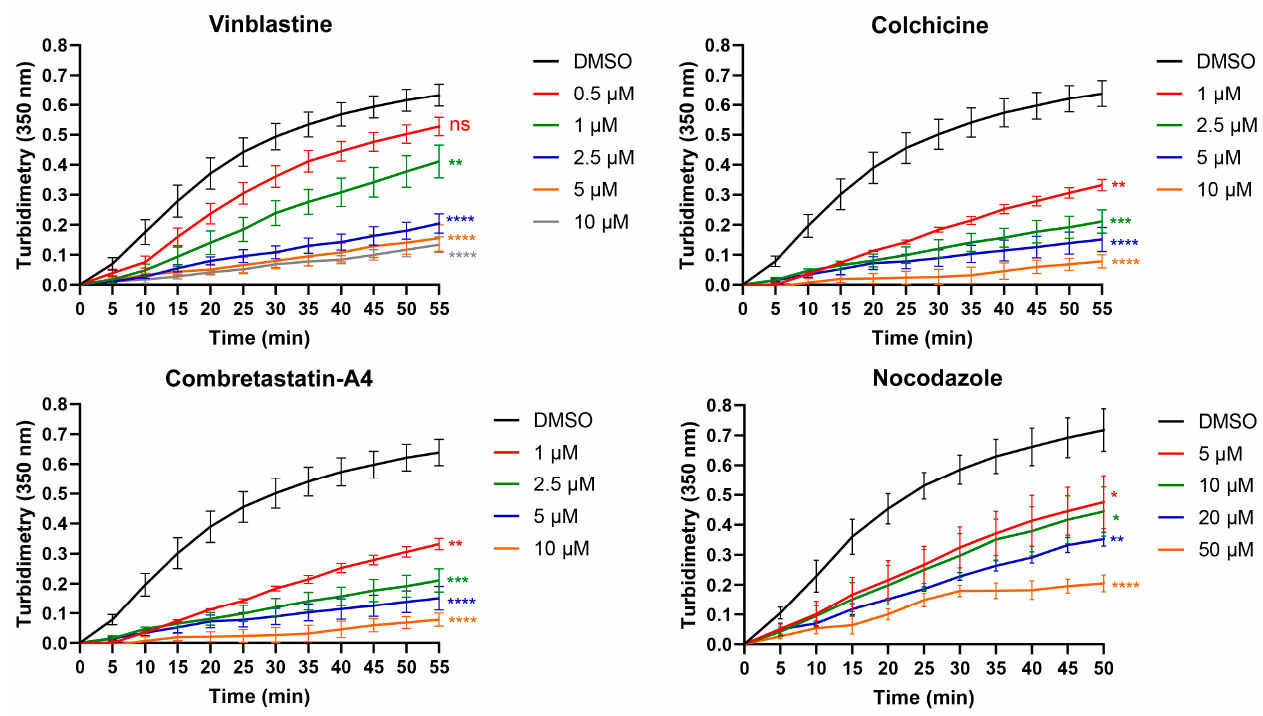
Figure 2. Effect of the reference compounds on the kinetics of in vitro tubulin polymerization. Time course of tubulin polymerization at 37 °C in the presence of vehicle (DMSO, black line) or the different compounds at several concentrations (colored lines) as indicated, measured by turbidimetry at 350 nm. Each turbidimetry value represents the mean ± SEM from 3–4 independent experiments. The significance was determined by a Student’s t-test (* p < 0.05, ** p < 0.01, *** p < 0.001, **** p < 0.0001 compared to DMSO).